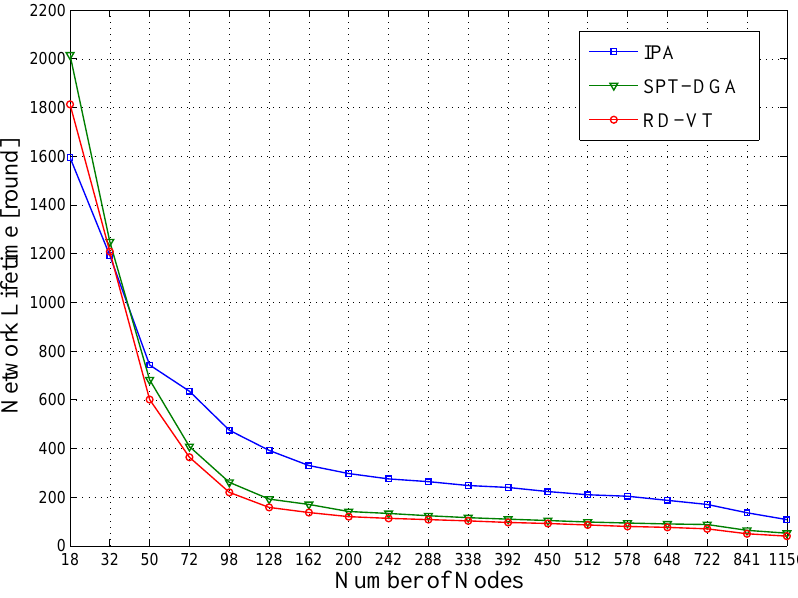
Figure 4. Network lifetime comparison for three algorithms. The x -axis is the scale of the network, and the y -axis is the network lifetime. SPT-DGA, shortest path tree based data gathering algorithm; RD-VT, rendezvous design for variable